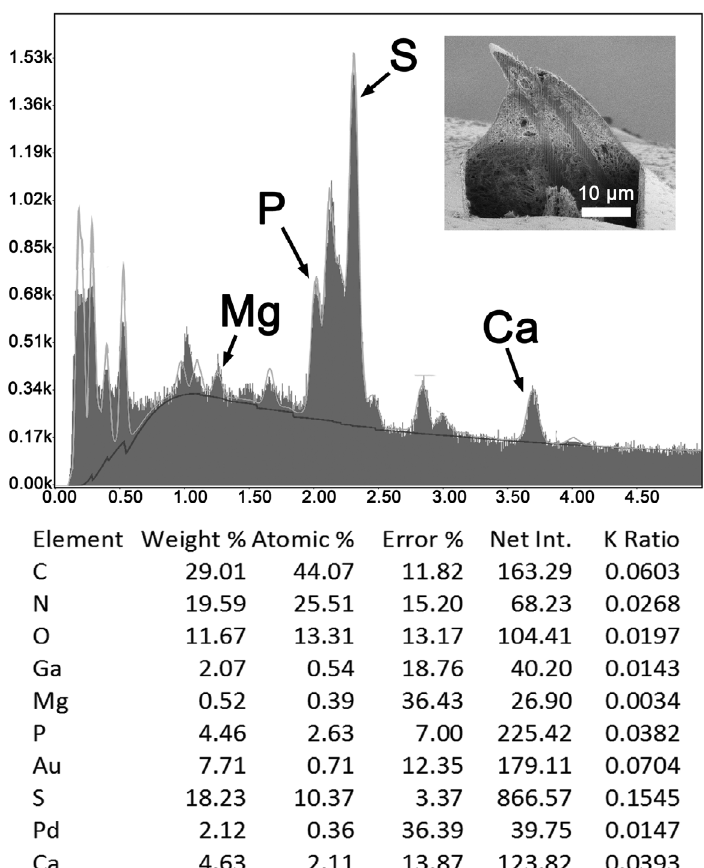
Figure 36. Energy Dispersive X-ray spectrum of the tip of a trunk spine of a Rhadinorhynchus laterospinosus specimen showing high levels of sulfur (see Table 5). Insert: SEM of a spine in lateral gallium